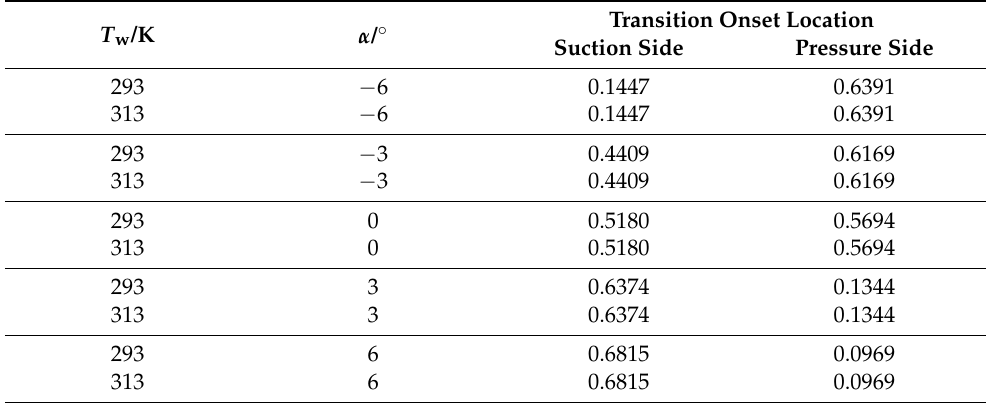
Table A2. Influence of surface temperature on transition onset location ( ε = 0.5%, Ma = 0.4).